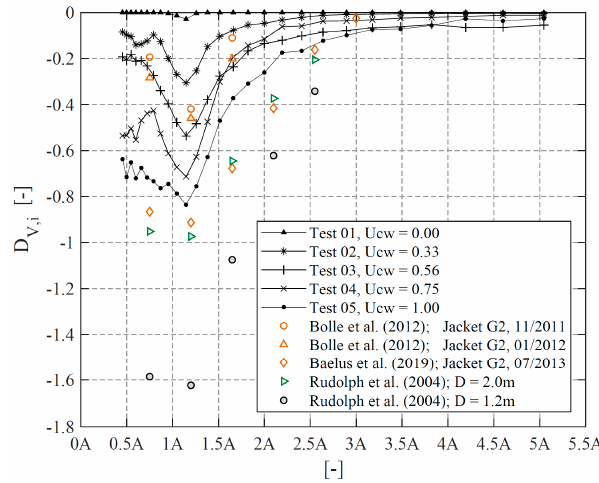
Figure 11. Global erosion of the dimensionless incremental erosion depth D V , i (see Equation (6)) around the jacket structure plotted over the structure footprint A, compared with in-situ field measurements of Rudolph et al. [8], Baelus et al. [9] and Bolle et al. [10].